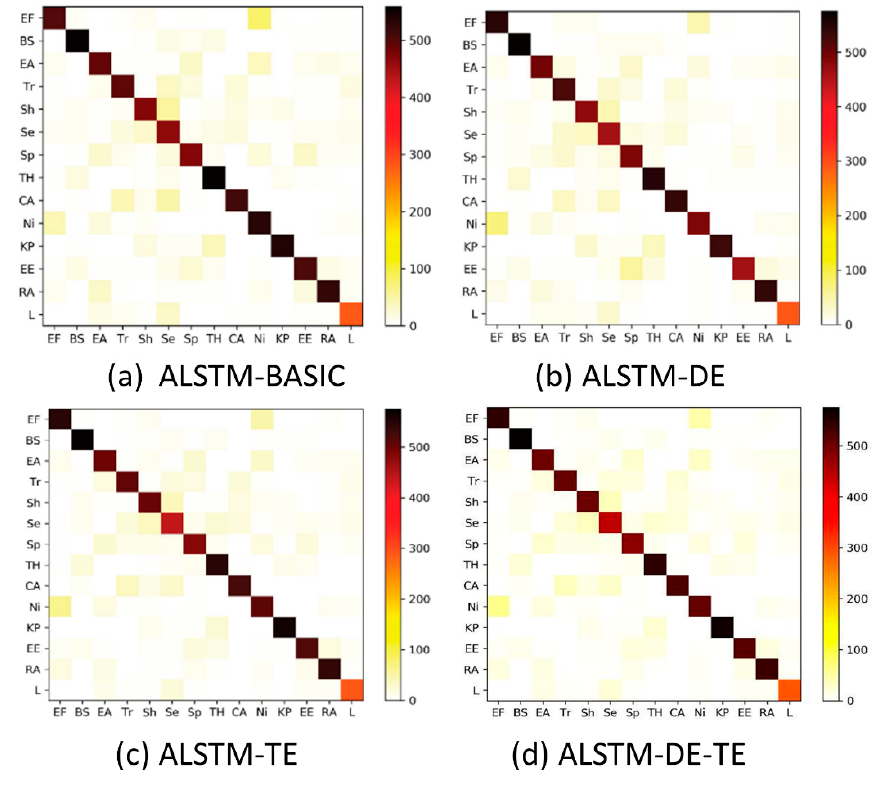
Figure 3. Heat maps of activities for the four models.